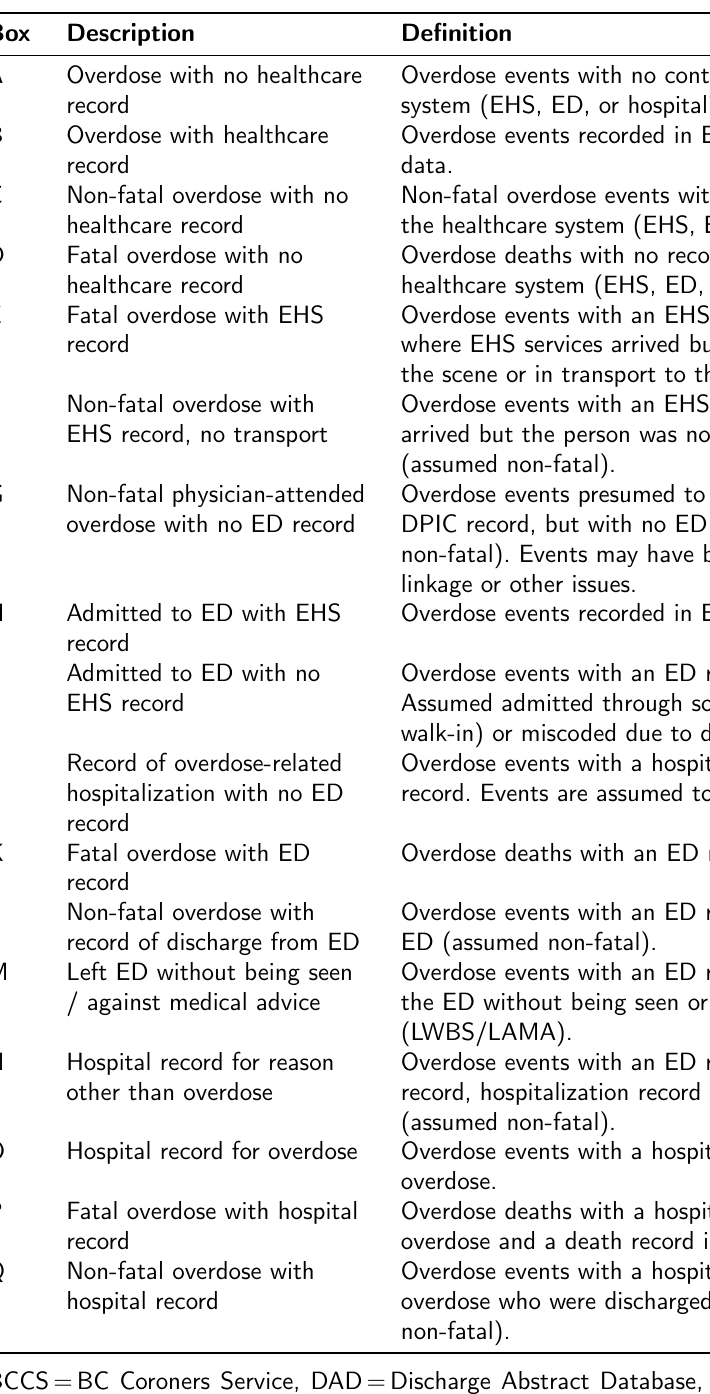
Table 1: Definitions and data sources for overdose events, BC provincial overdose cohort,